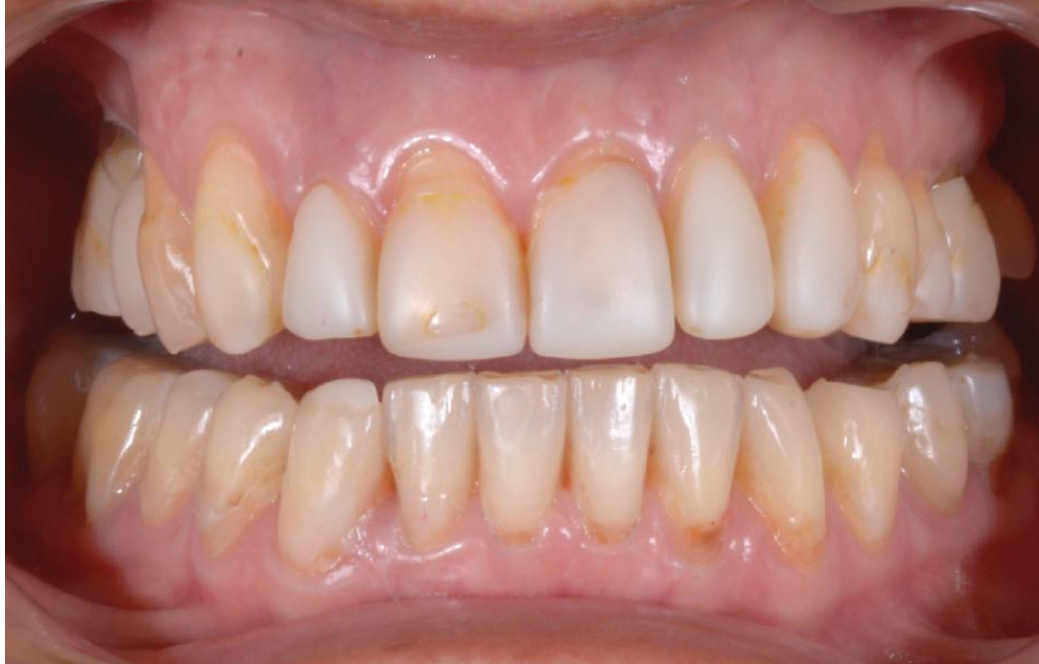
Figure 9. Result after 6 months of aligners.